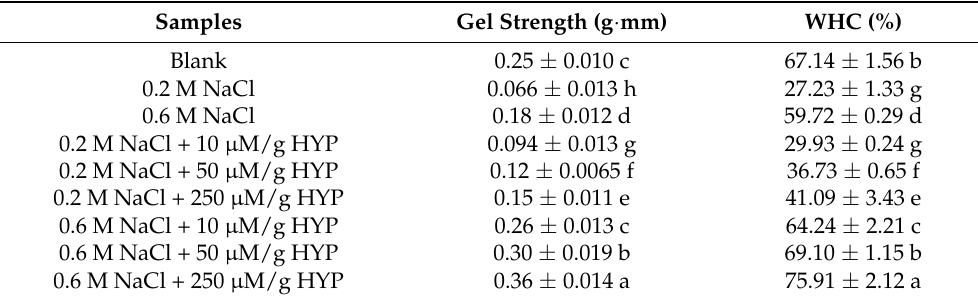
Table 2. Gel strength and WHC of non-oxidized MPs gel (blank) and oxidized MPs gels prepared with HYP (10, 50, and 250 µ M/g) at different NaCl concentrations (0.2 and 0.6 M). Samples Gel Strength (g ·